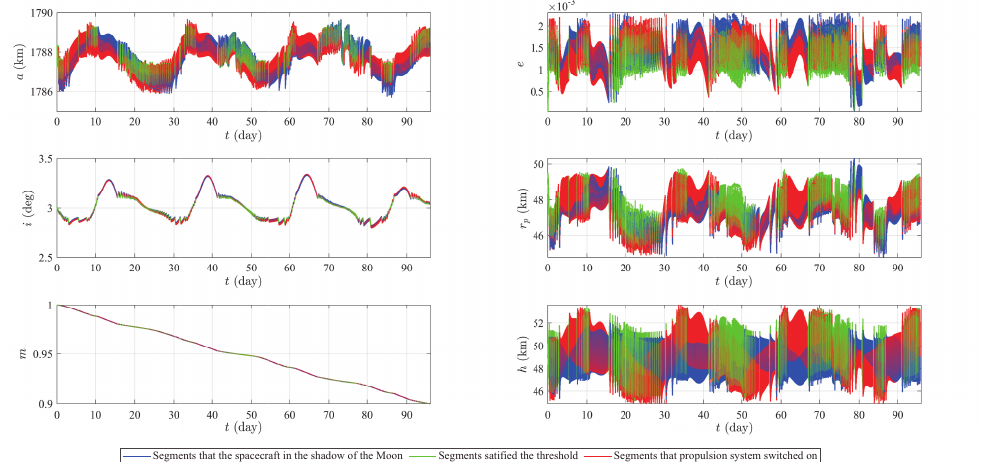
Figure 6. The variation of orbit elements in the process of orbit maintenance with thrust (cid:107) T (cid:107) = 30 mN, Ω = 240 ◦ and i = 3 ◦